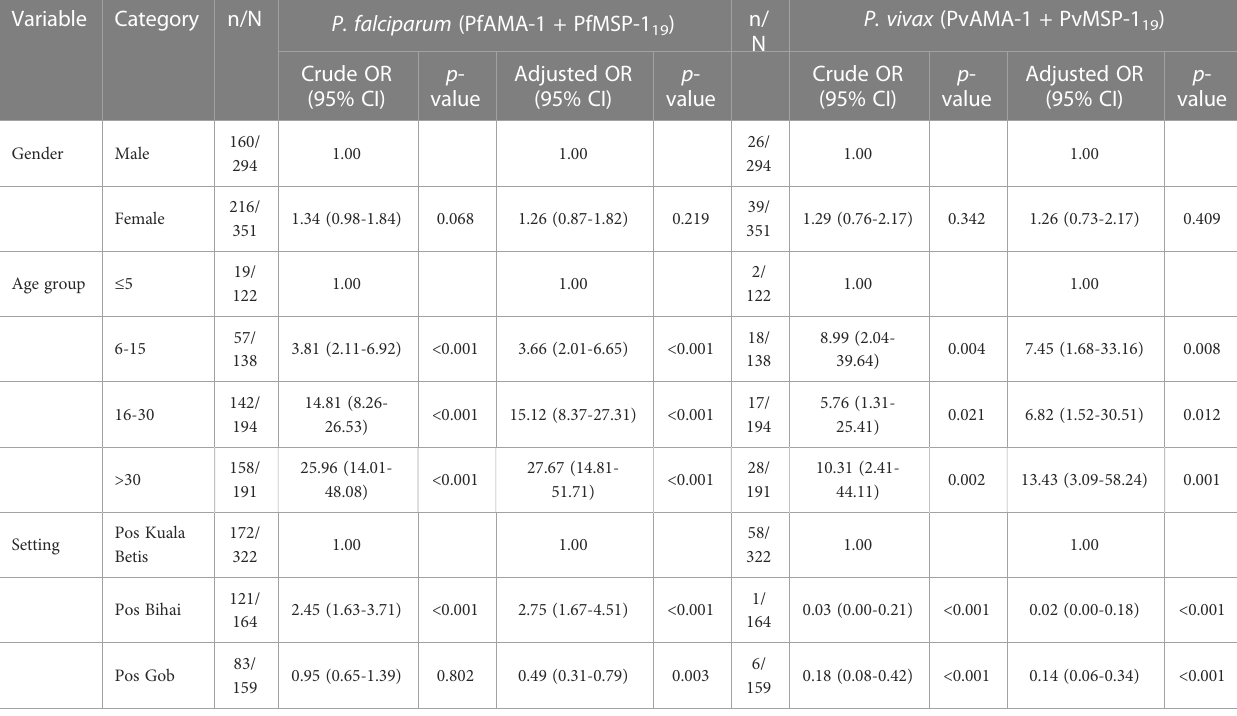
TABLE 3 Logistic regression analysis of seropositivity to any P. falciparum- and P. vivax -speci fi c antigens among indigenous Orang Asli communities in Kelantan state, Peninsular